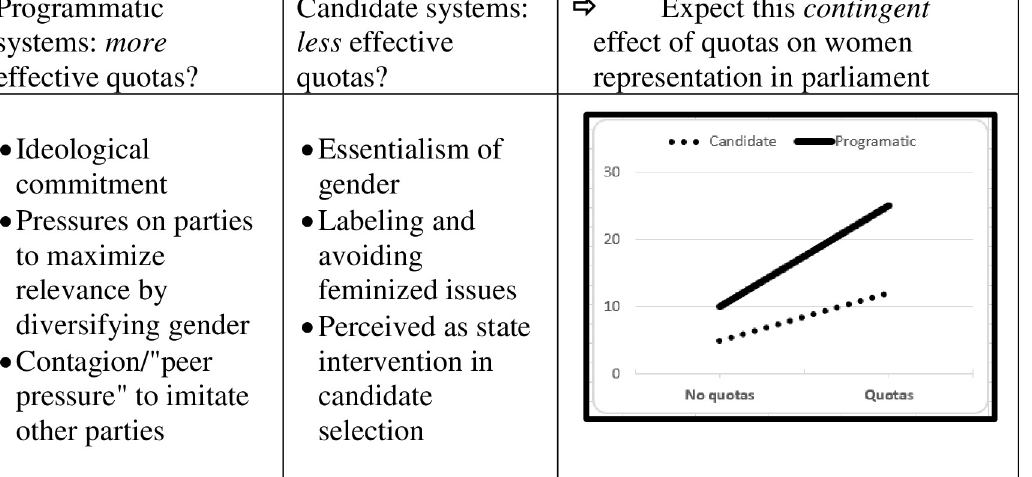
PLOS ONE | https://doi.org/10.1371/journal.pone.0257665 September 23,